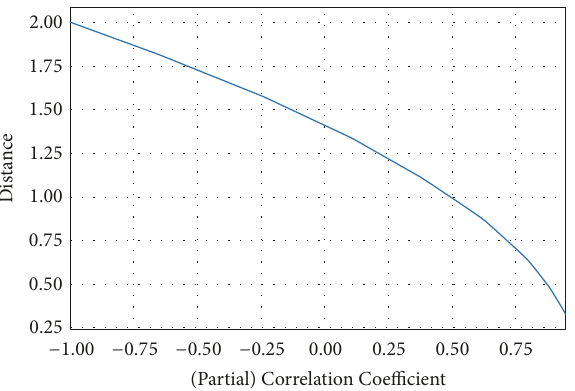
Figure 5: The relationship between partial or correlation coefficients and distance